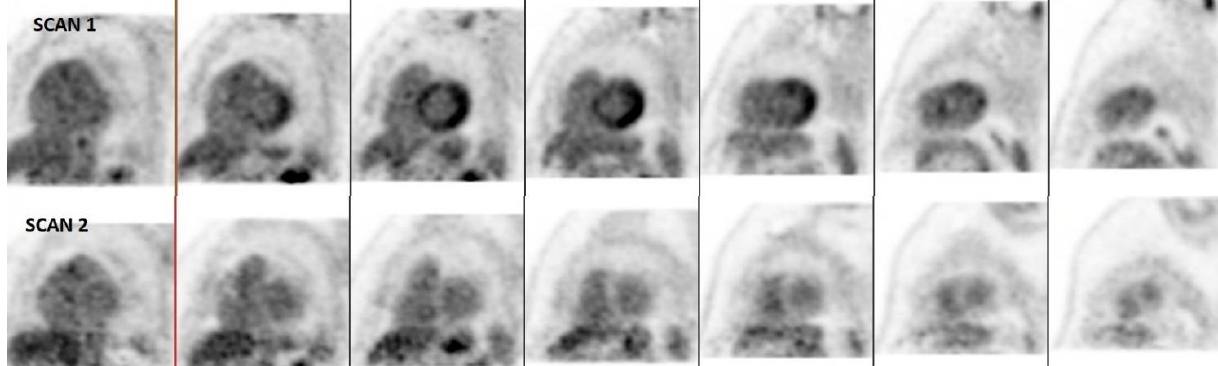
Figure 5. FDG PET-CT images at the time of diagnosis ( SCAN 1 ) and 3 months after cessation of corticosteroids ( SCAN 2 ). Slice 12 mm. Zoom × 3.